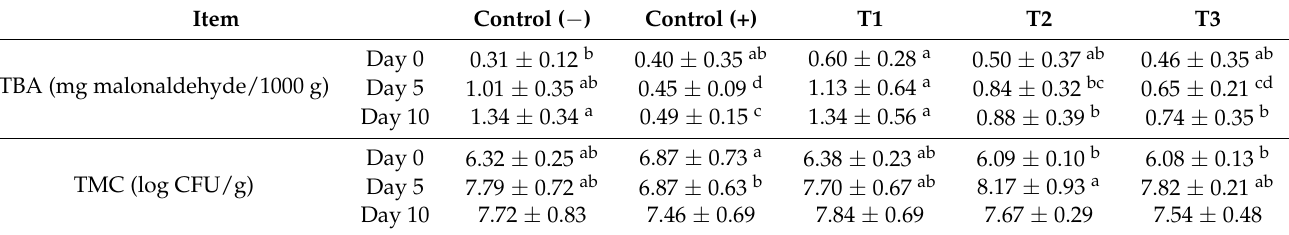
Table 7. Storage properties of pork patties with fermented soy